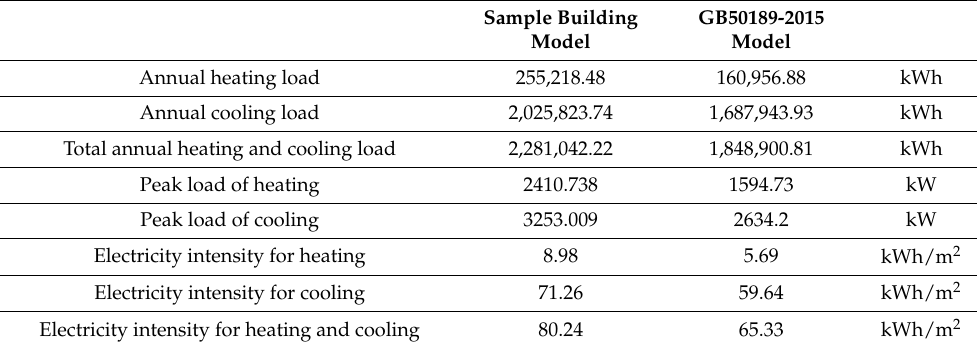
Table 5. Comparison of the simulation results of the sample building model with the GB50189-2015